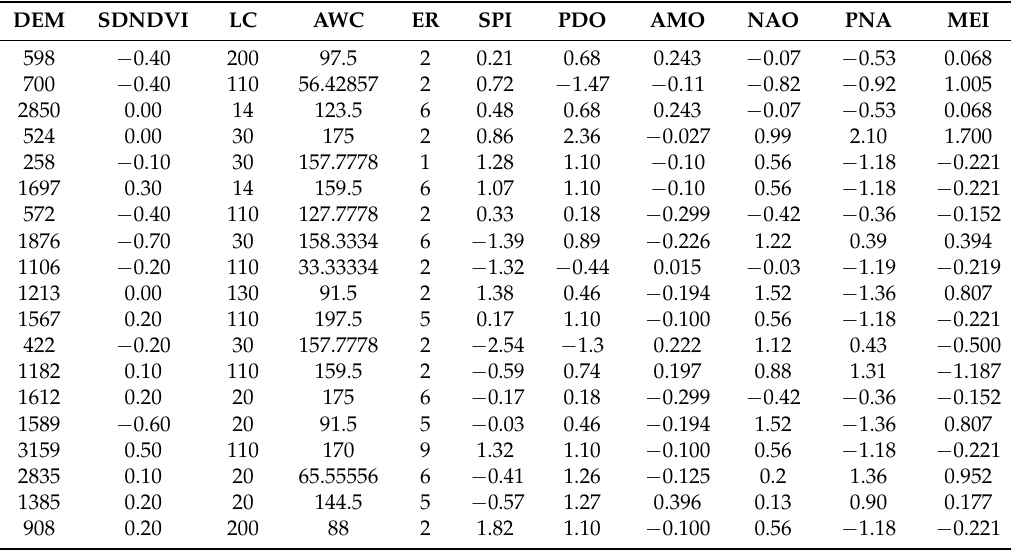
Table 1. An excerpt from the list of attributes and data used for modeling